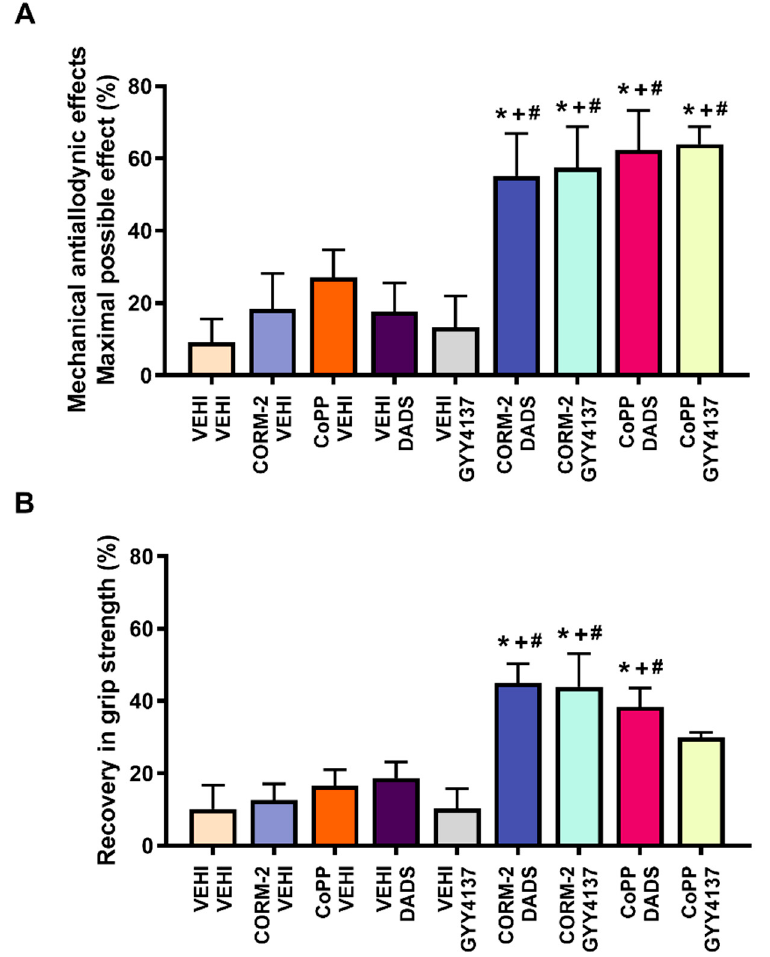
Figure 3. Effects of the co-administration of a CO-releasing molecule and an HO-1 inducer with two H 2 S donors on MIA-induced mechanical allodynia and loss of grip strength . The mechanical antiallodynic effects ( A ) and the recovery of grip strength ( B ) induced by the acute intraperitoneal administration of 5 mg/kg of CORM-2, 0.5 mg/kg of CoPP, 3 mg/kg of DADS, or 0.4 mg/kg of GYY4137 administered alone or combined are displayed. For each test, * denotes significant differences vs. vehicle plus vehicle-treated mice; + vs. CORM-2 or CoPP plus vehicle-treated mice and # vs. vehicle plus DADS- or GYY4137-treated mice ( p < 0.05; one-way ANOVA, followed by the Student–Newman–Keuls test). Data are expressed as the mean values of the maximal possible effect (%) for the mechanical allodynia and the recovery in grip strength (%) ± SEM; n = 6 animals per dose and treatment.